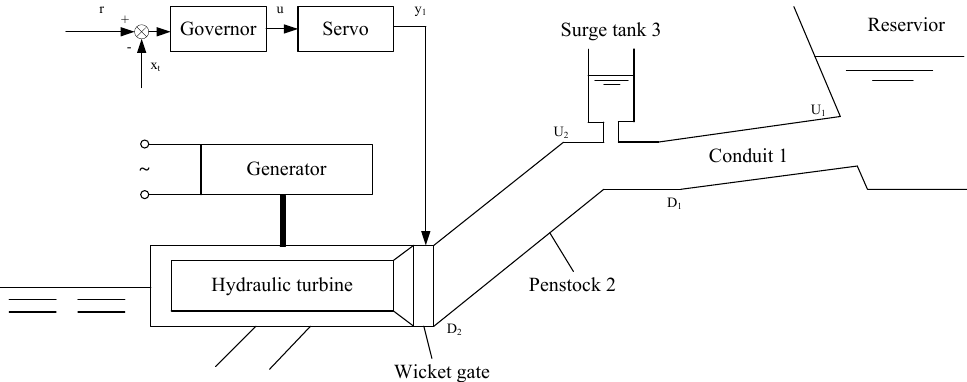
Figure 1. A typical hydraulic turbine governing system layout with a complex conduit